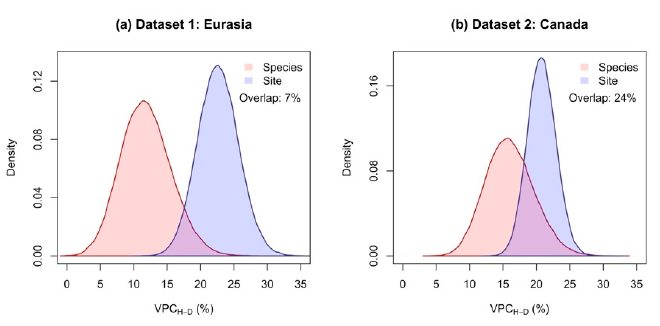
Figure 5. The VPC H-D , showing the proportion of variance caused by differences between species and differences between sites in the variability of H-D ratio (ratio between height and diameter at breast height).